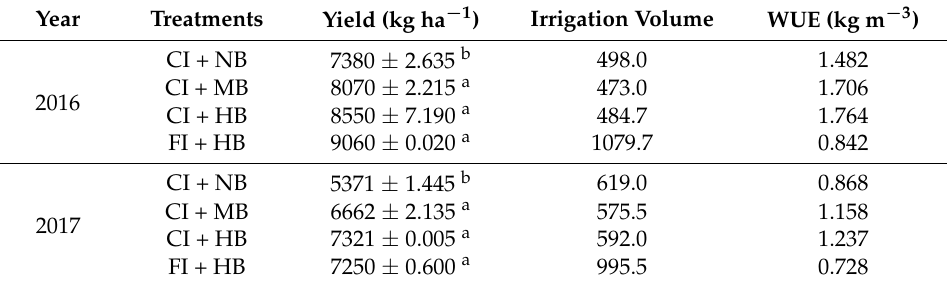
Table 4. Rice yield and water use efficiency under different treatments.